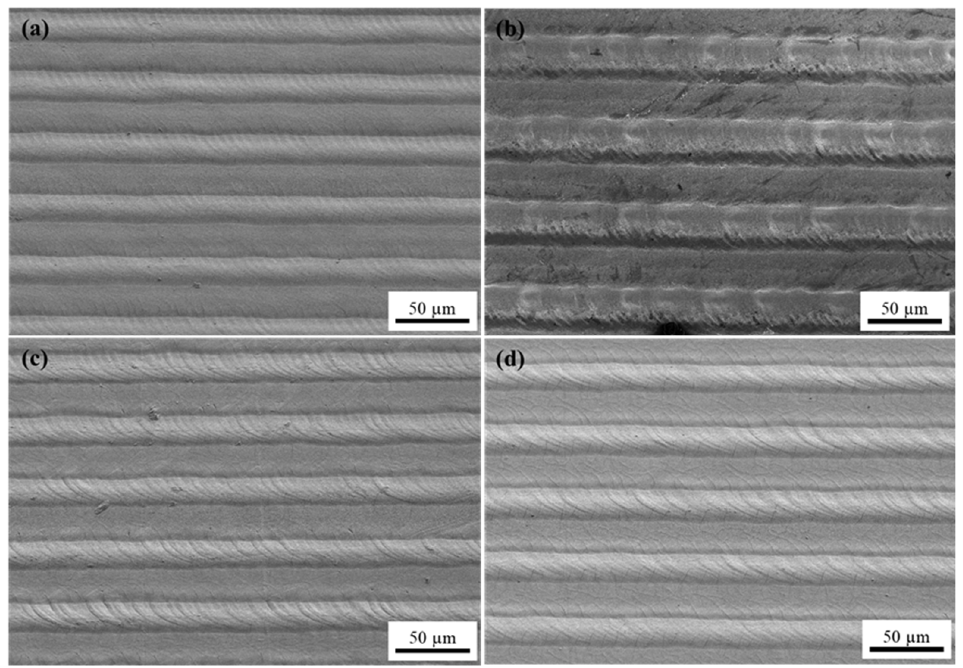
Figure 5. SEM images of the laser-textured surfaces in ( a ) CP-Ti N0, ( b ) CP-Ti N20, ( c ) Ti64 N0 and ( d ) Ti64 N20 samples.